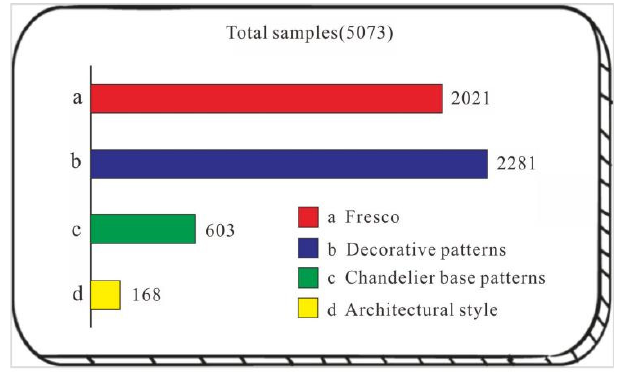
Figure 2. The type and quantity of